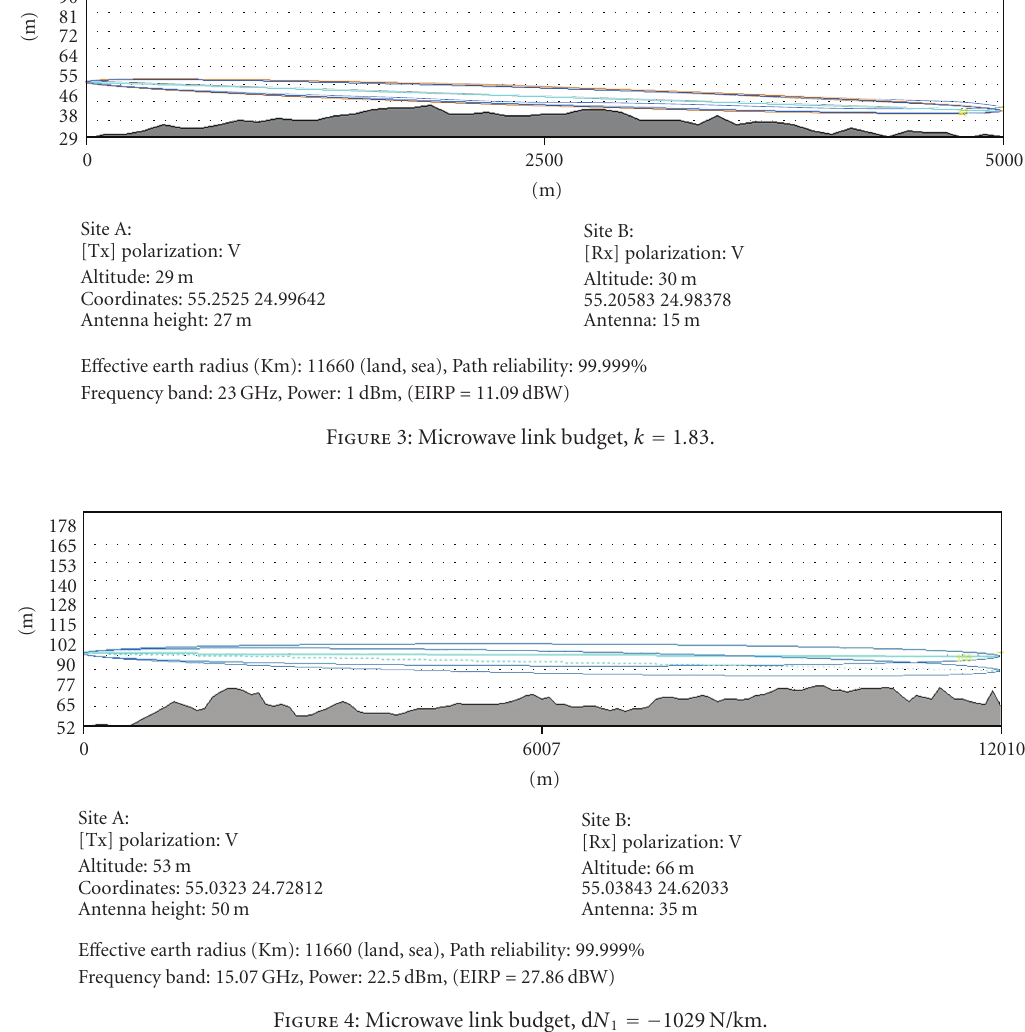
Figure 4: Microwave link budget, d N 1 = − 1029 N/km.